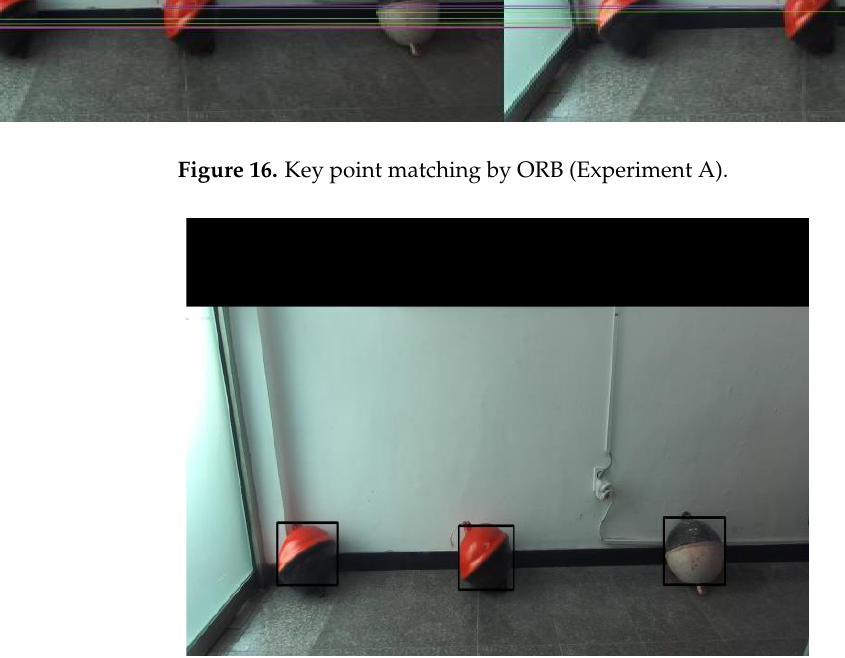
Figure 17. Feature-based stereo matching results (Experiment A). The distance from the buoys to the camera based on the monocular vision was calculated by extracting the bottom center point of the bounding box from the ZED left camera image. The distance from the buoys to the camera based on stereo vision was calculated using the disparity, which is the image coordinates ’ difference of the bottom center point of the bounding box between the ZED left and right camera image results from stereo matching. The results were compared with the distance between buoys and the camera measured using a laser distance measuring device, as shown in Table 7. Table 7. Comparison of distance calculation with distance measurement (Experiment